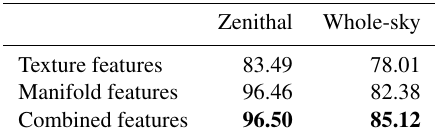
Table 3. The 10-fold cross validated classification accuracy (%) on two datasets. The best results are labelled in bold